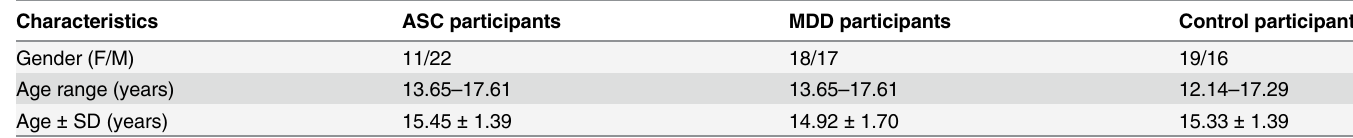
Table 1. Demographic characteristics of the participants.